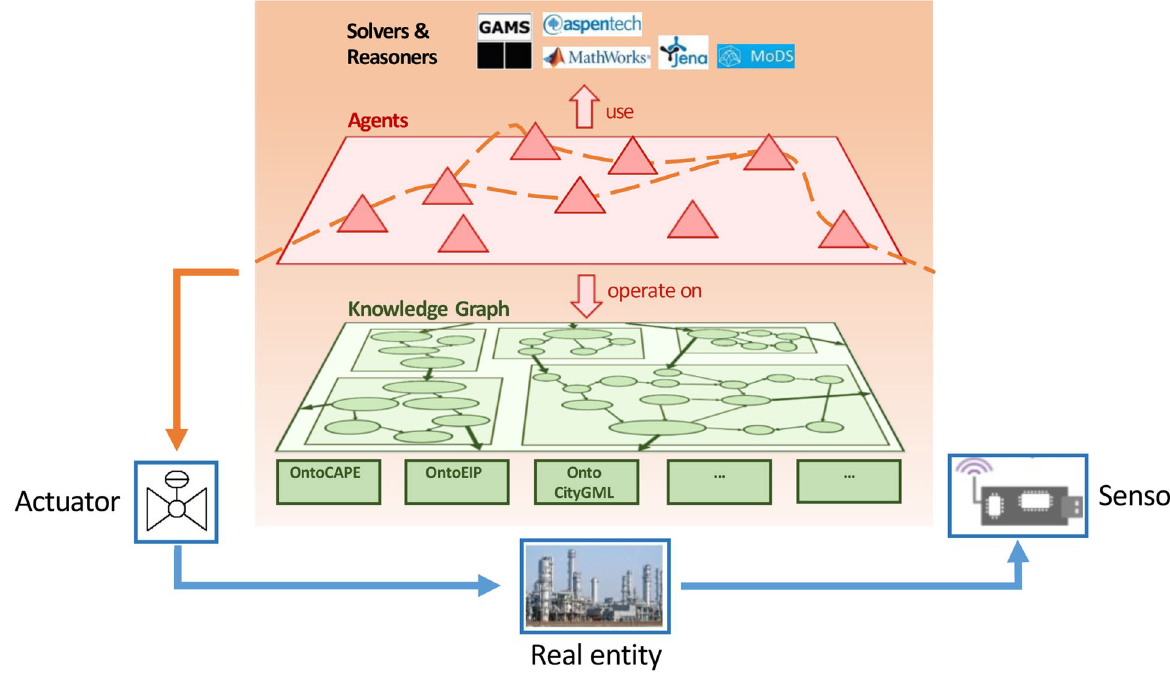
Fig. 6 System architecture of J-Park